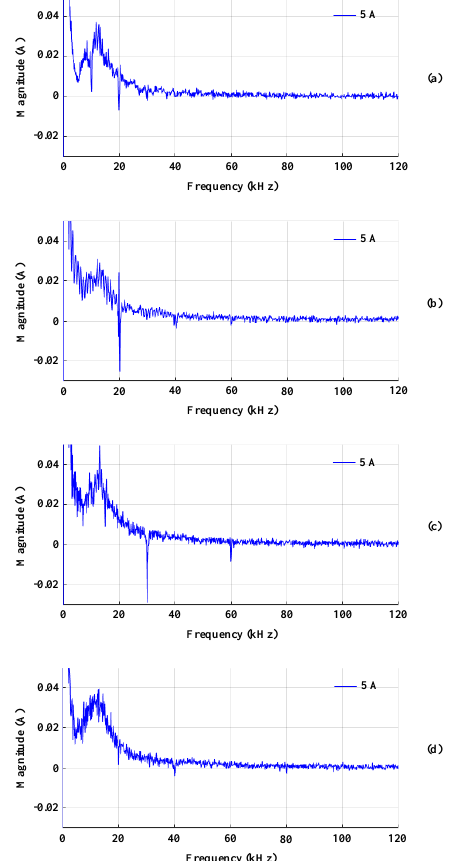
Figure 10. FFT differences after and before arc generation based on the current magnitude and switching frequency in 𝐼 𝑎𝑟𝑐3 : ( a ) 5 kHz, ( b ) 10 kHz, ( c ) 15 kHz, and ( d ) 20 kHz.